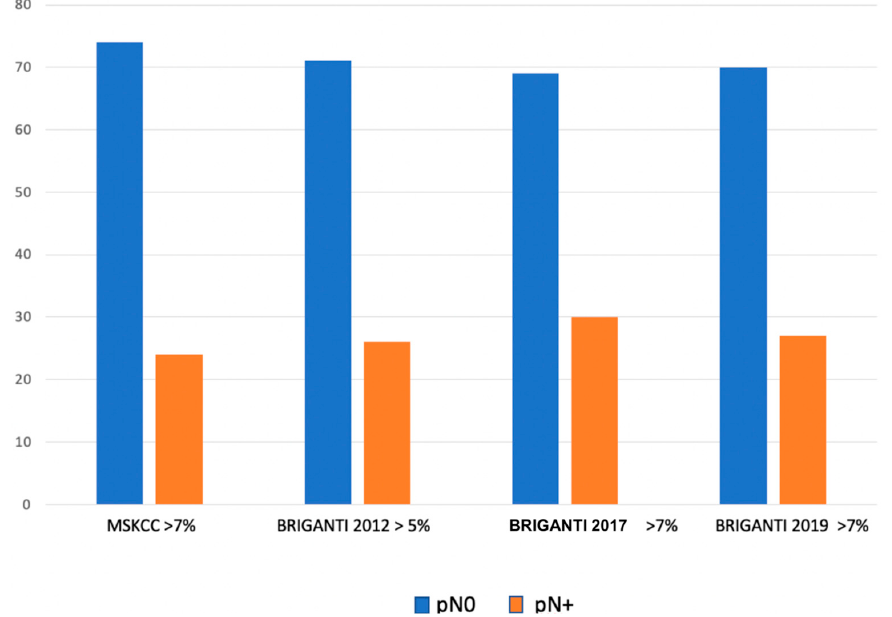
Figure 2. Bar-chart showing pN0 and pN+ cases distribution according to the MSKCC (at estimated risk >7%), Briganti 2012 (at estimated risk >5%), Briganti 2017 (at the estimated risk >7%), Briganti 2019 (at estimated risk >7%) nomograms. Table 5. Logistic regression analysis to identify predictors for positive lymph node (pN+).